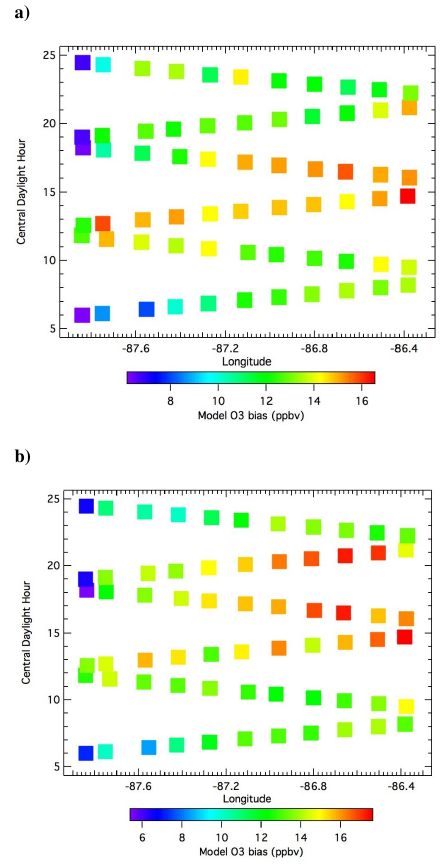
Figure 13. CMAQ model bias from (a) 1 to 24h forecast and (b) 25 to 48h forecast.